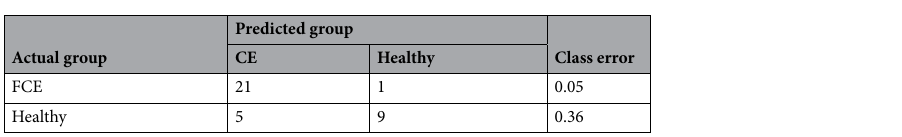
Table 3. Random forest classification into healthy cats or cats with feline chronic enteropathy (FCE). Overall out of bag (OOB) error rate is